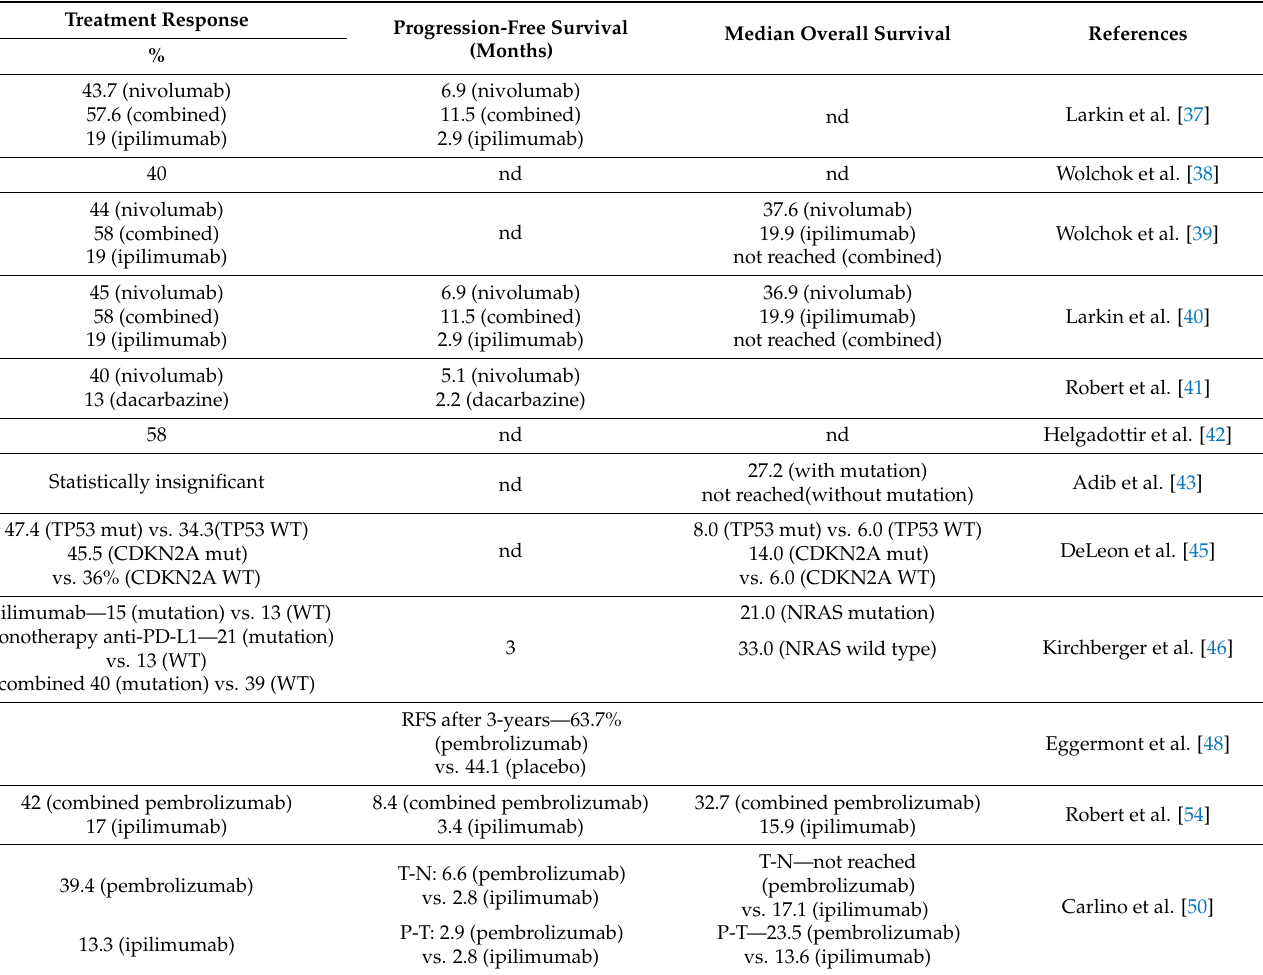
Table 3. Effects of immunotherapy in patients with cutaneous melanoma. Nd—no data; WT—wild- type; T-N—treatment-naive; P-T—previously